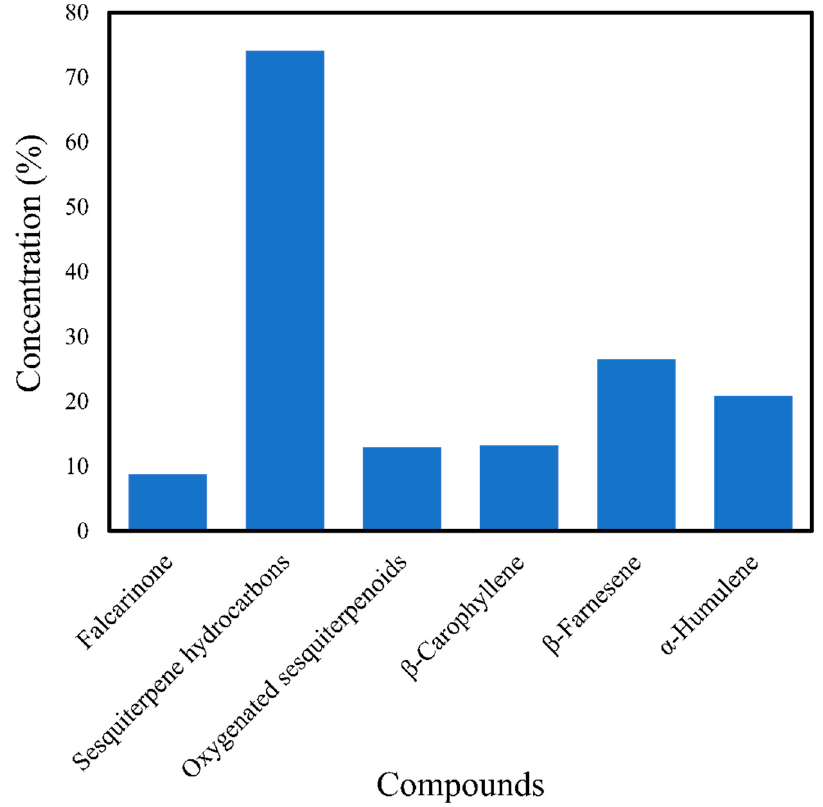
Figure 3. Compounds obtained from Centella asiatica using the distillation method of Paudel et al. [32].